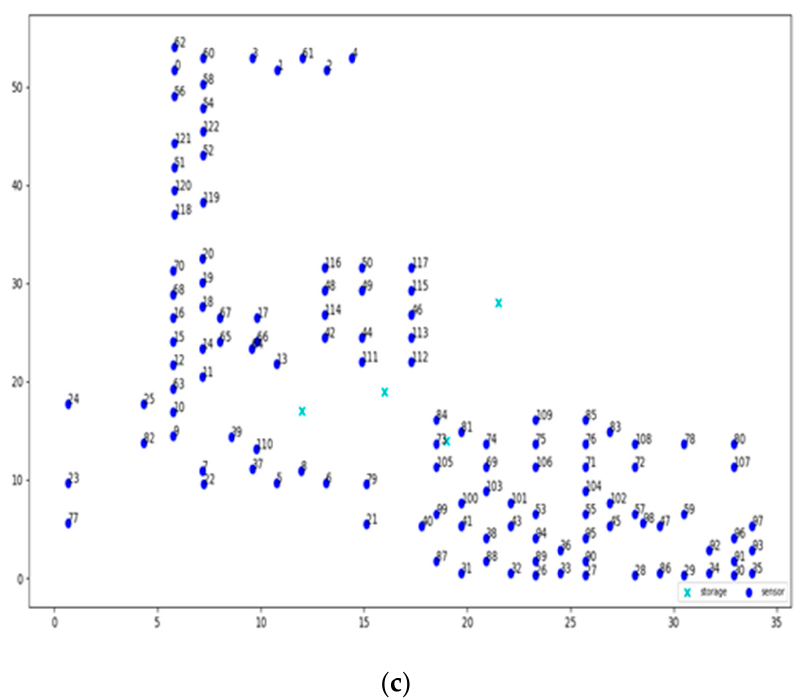
Figure 5. The topologies of experiments as provided by FIT-IoT lab ( a ) 37 nodes, ( b ) 100 nodes, ( c ) 123 nodes.